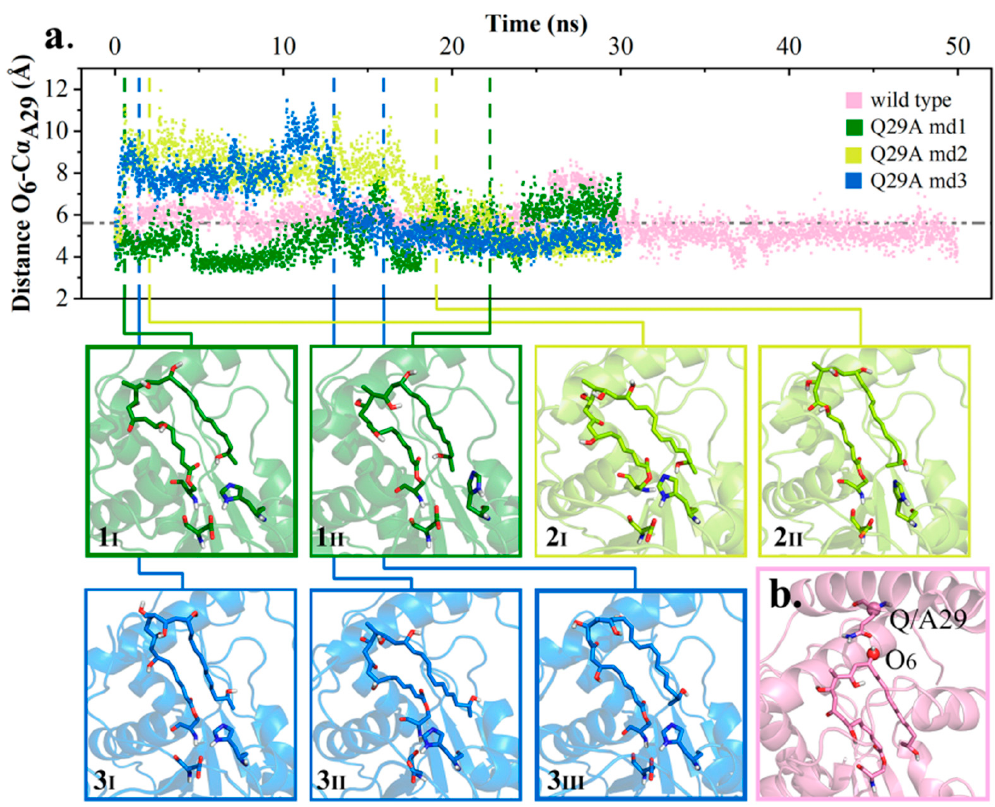
Figure 6. Instability of polyketide conformation. ( a ) Distance O 6 -C Q/A29 in wild type md4 and Q29A md1–3 along with conformation transformation. ( b ) Diagram of distance O 6 -C Q/A29.